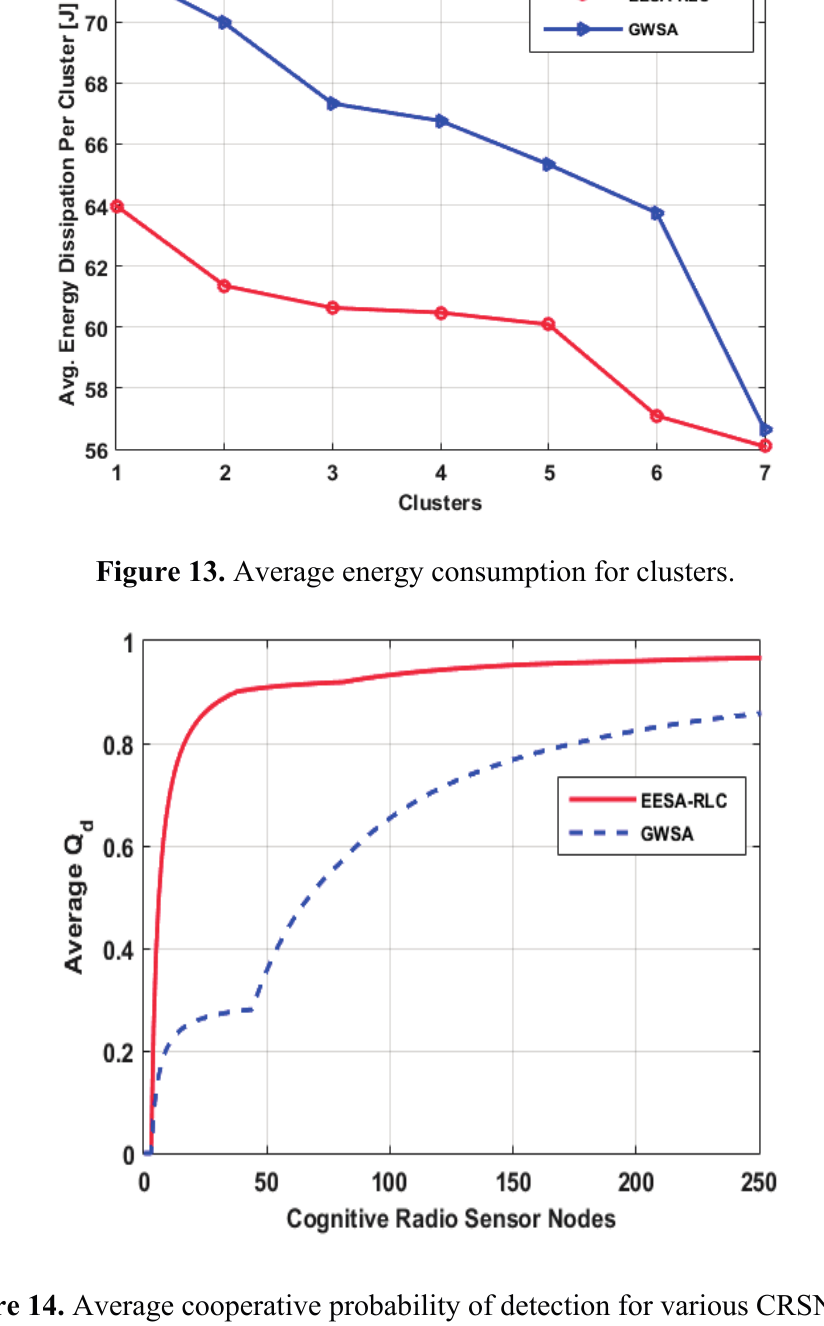
Figure 14. Average cooperative probability of detection for various CRSN